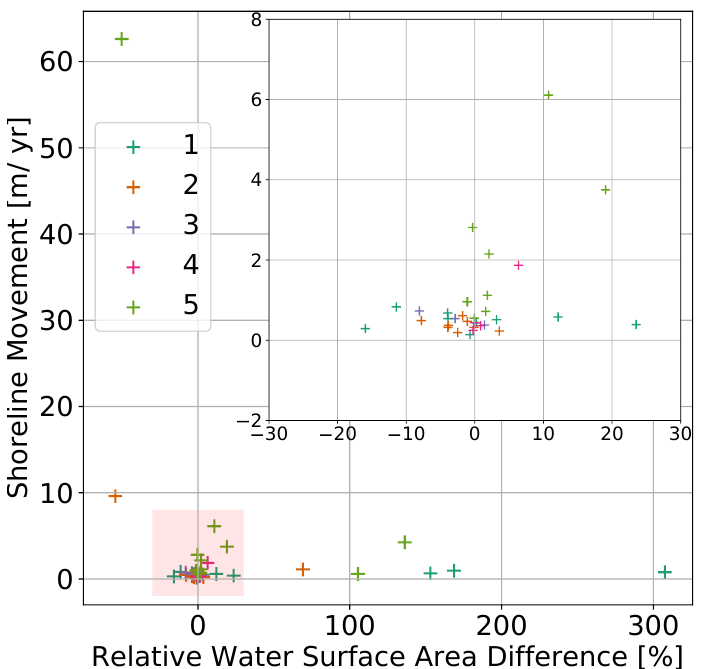
Figure A2. Scatter plot showing annual shoreline movement rates and the corresponding water surface area difference for each lake size category. The values within the red square are shown in the inset graph in the top right corner.